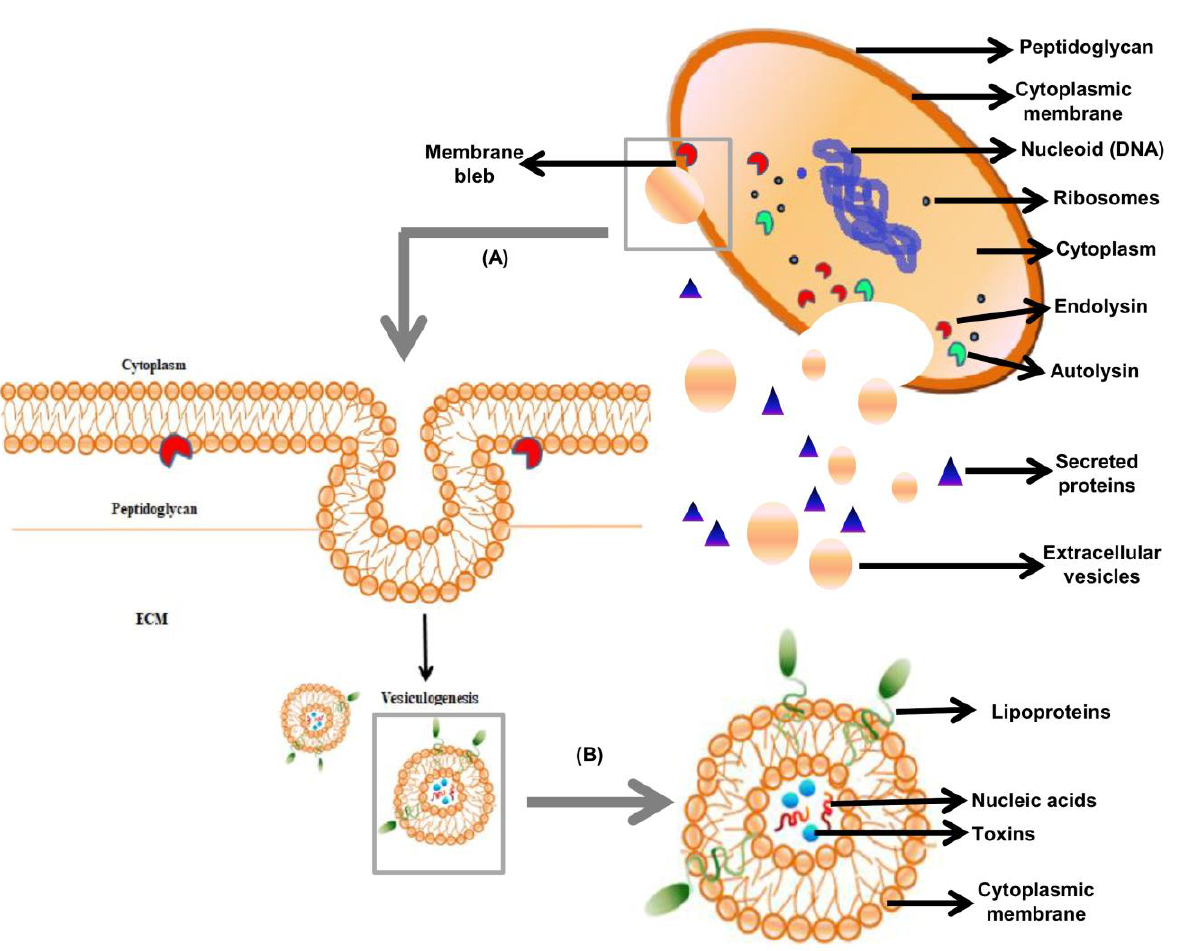
FIGURE 1: Origin and composition of gram-positive EVs . (A) The release of EVs involves diversified events depending on the cell lytic enzyme viz. PGN degradation followed by cytoplasmic membrane bleb protrusion via endolysins and PGN remodelling via hydrolyzing enzyme autoly- sins. (B) The internal structure of EVs comprising of nucleic acids, virulence factors, and intracellular